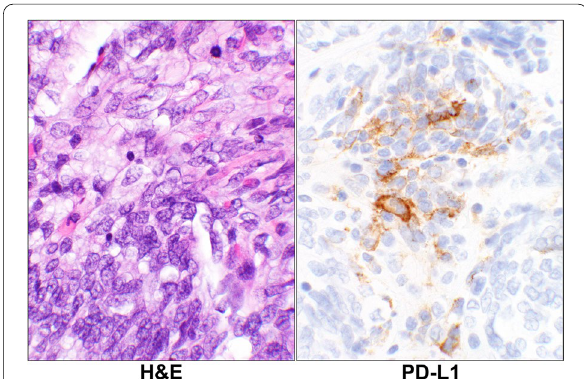
Fig. 7 IHC reaction in STUMP. H&E stain of a case of smooth muscle tumor of low malignant potential with mildly atypical cells (case# 67, Additional Table 1). The corresponding PD-L1 stain showing focal cell membrane staining of the neoplastic cells. A single cell shows the strong cell membrane reaction. (40 objective). Abbreviations: H&E, × hematoxylin & eosin; PD-L1, programmed death-ligand